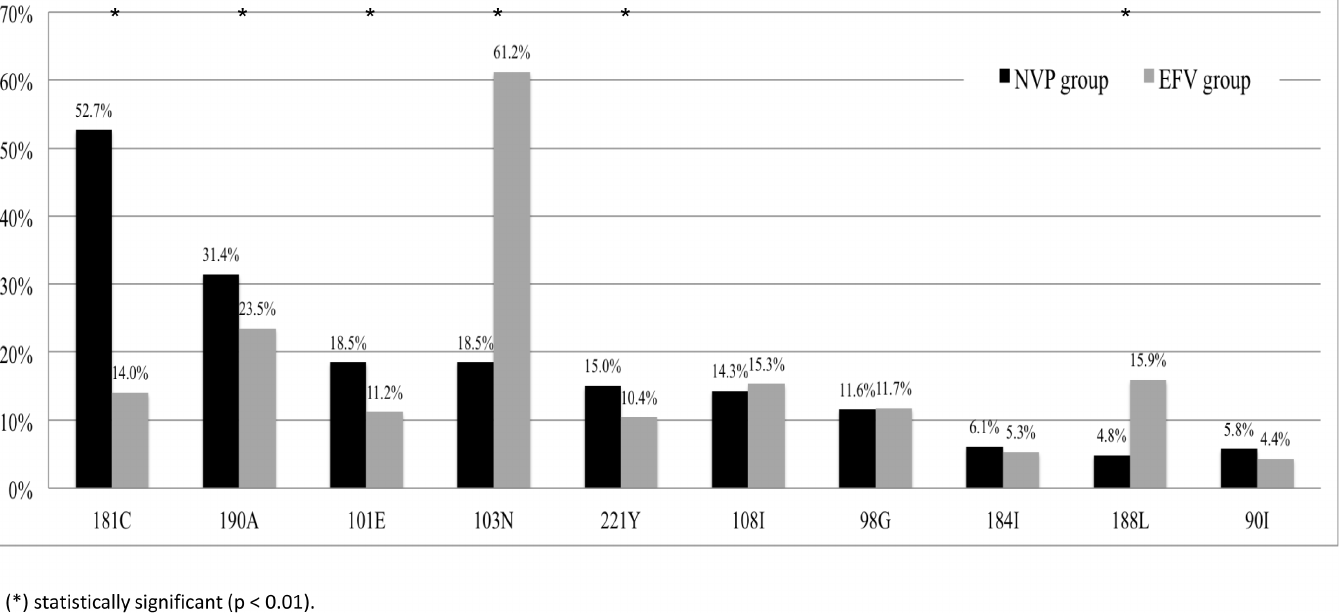
Fig 1. Top 10 NNRTI-RAMs found in patients who failed either the NVP- or EFV-based